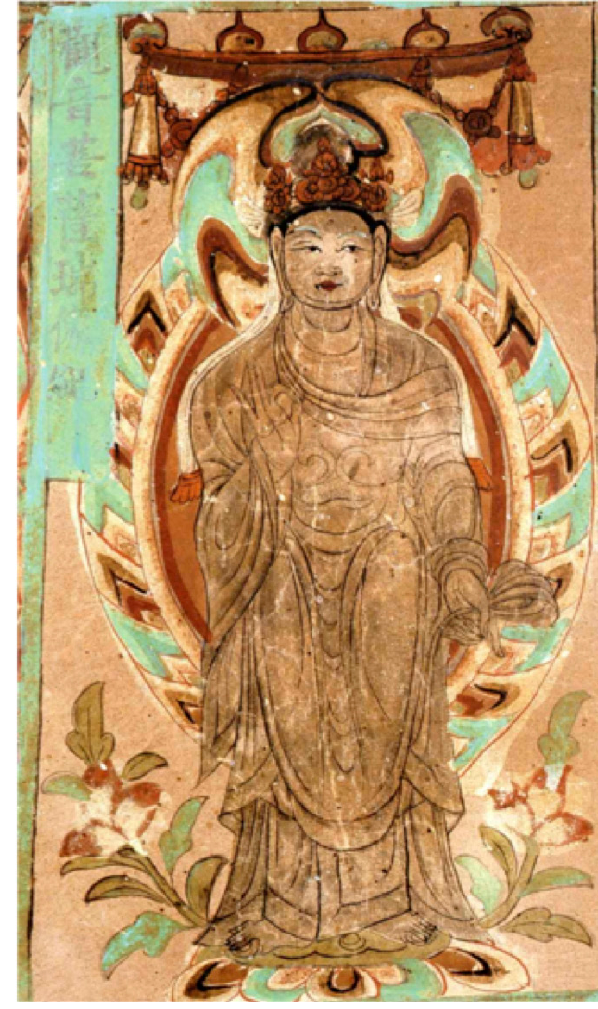
FIgure 4 Auspicious Statue of Avalokiteśvara (D- Auspicious Statue of MG 72, Five Dynasties; adapted from Maitreya (D-MG 231, Sūn Xiūshēn 2000, 63, ill. 46): 觀音菩薩 mid-Táng; adapted 瑞相紀 - Record of the Auspicious Statue from Sūn Xiūshēn of Guānyīn (Avalokiteśvara) Bodhisattva 2000, 61, ill. 44): 天 竺白銀彌勒瑞相 - The (The original statue was supposedly situated in Auspicious Statue of the ‘Silver-Maitreya’ of India.